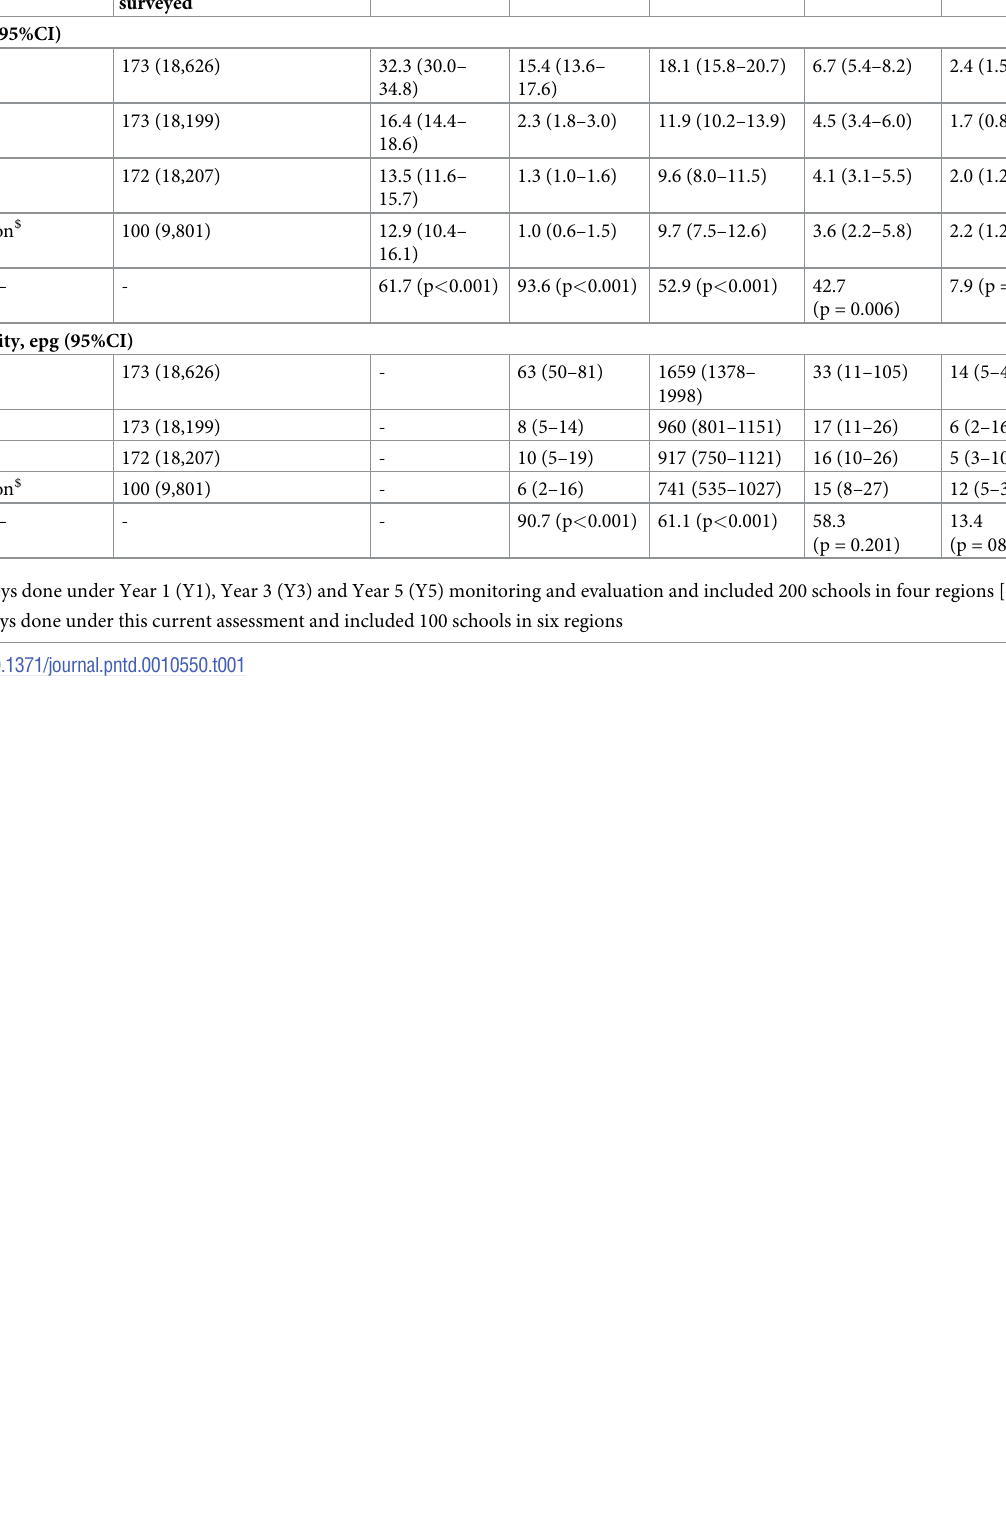
Table 2. Overall prevalence % (95%CI), mean intensity epg (95%CI) of infections and relative reductions (RR) % (p-value) among school children in Kenya after five rounds of MDA.